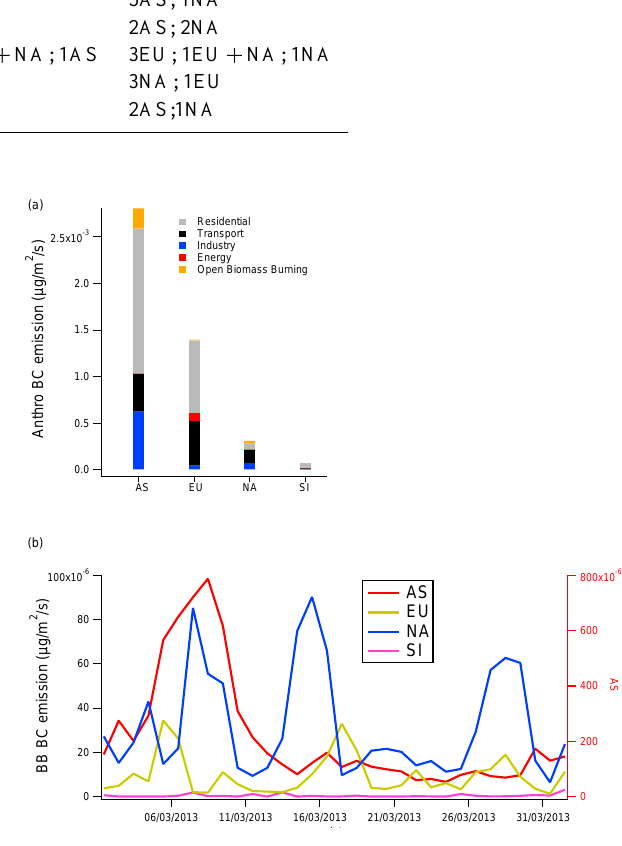
Figure 7. BC emissions characterized by source region (as defined in Fig. 2). (a) comparison between different source sectors; (b) the temporal evolution of OBB sources throughout the experimental pe- riod. Note for AS, the right axis is